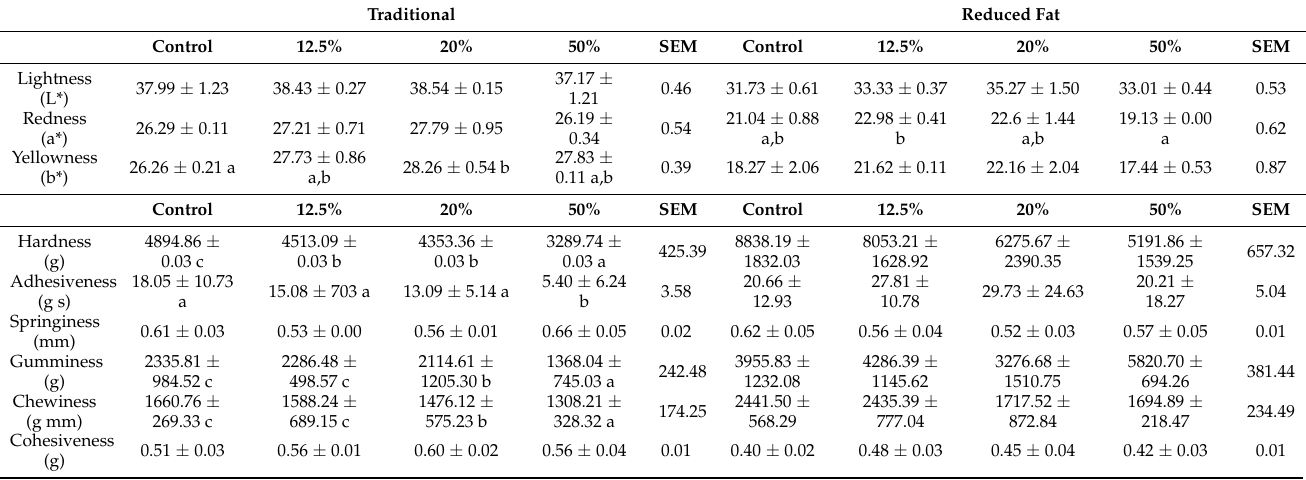
Table 3. Mean values, standard deviation, and standard error of the mean (SEM) of the color and texture properties for the traditional and reduced fat “Chorizo Zamorano” formulations at the end of